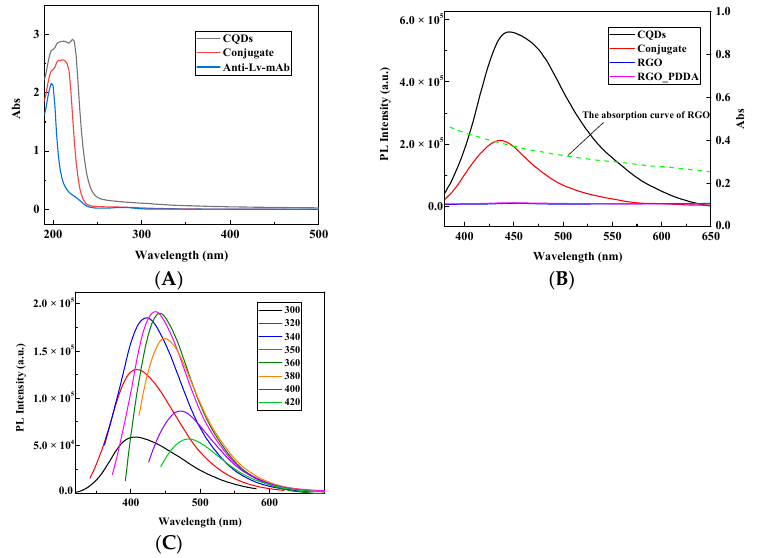
Figure 4. ( A )UV-VisabsorptionspectraofCQDs, Anti-Lv-mAbandtheconjugateofAnti-Lv-mAb/CQDs, the absorption spectrum of CQDs was used as reference; ( B ) PL spectra of CQDs, Anti-Lv-mAb/CQDs, and RGO and RGO_PDDA under excitation at 350 nm. The PL spectrum of CQDs is used as reference, and the dashed line is the absorption curve of RGO; ( C ) PL spectra of Anti-Lv-mAb/CQDs under various excitation